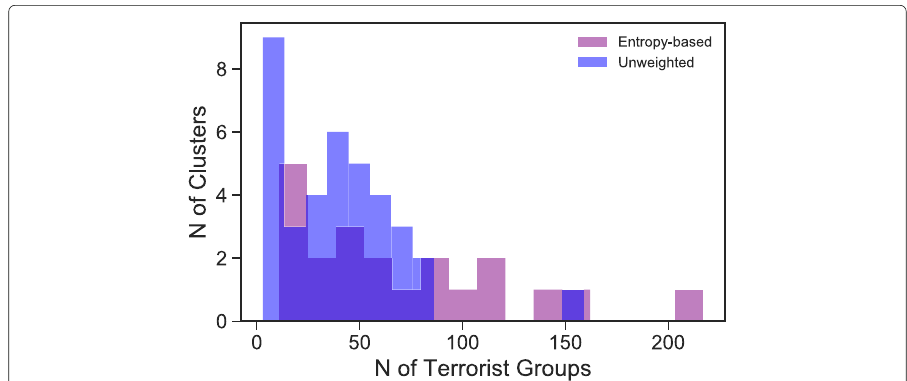
Fig. 3 Distribution of Cluster Assignments per Different Approach. The unweighted approach produces a higher number of small clusters, highlighting a higher